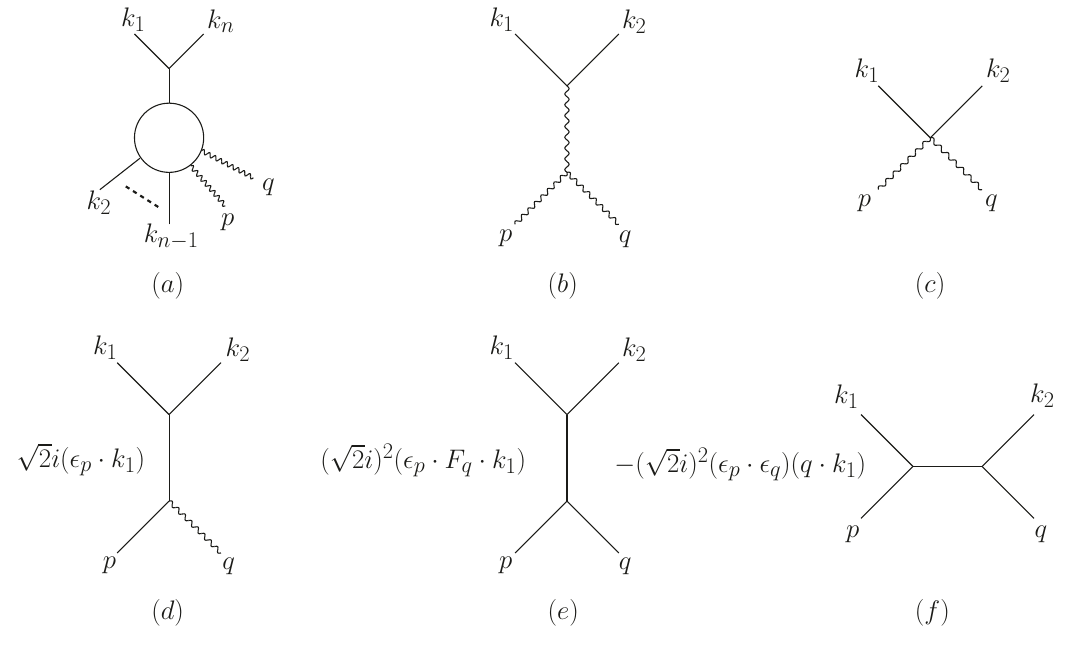
Figure 1 . Boundary of the left hand side of relation for amplitudes with more than two scalars and two